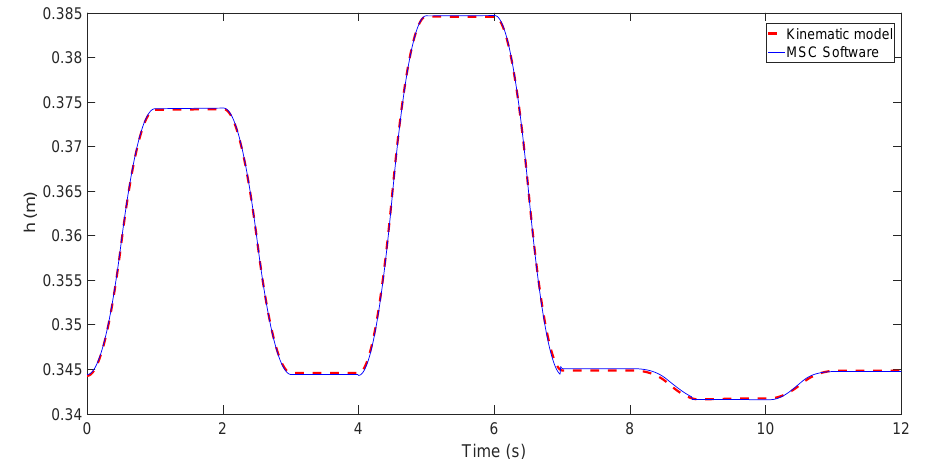
Figure 8. Validation of the height of the centre of frame {F}.